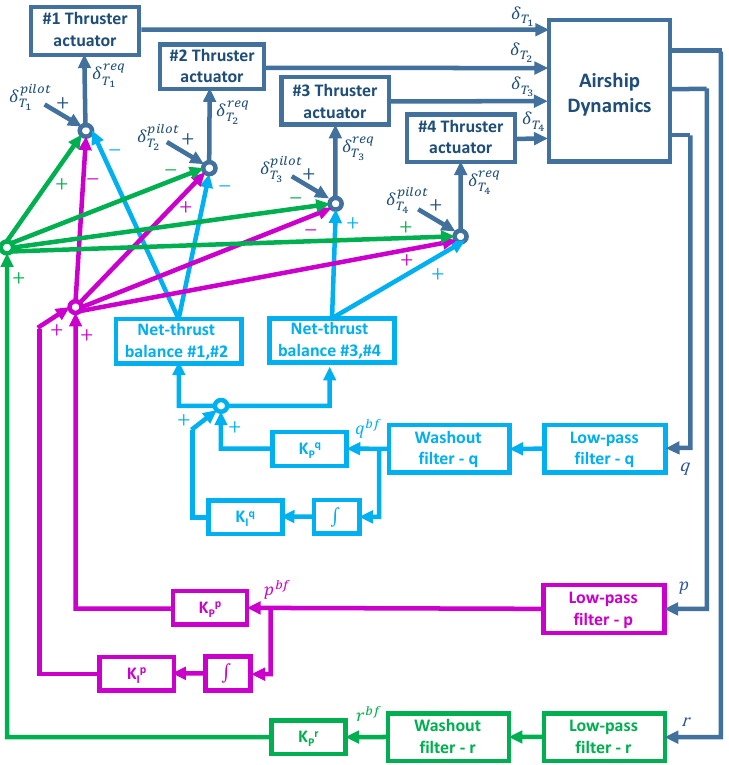
Figure 4. Stability augmentation scheme proposed for the four-thrusters layout concept introduced in Figure 3. Same color scheme as for Figure